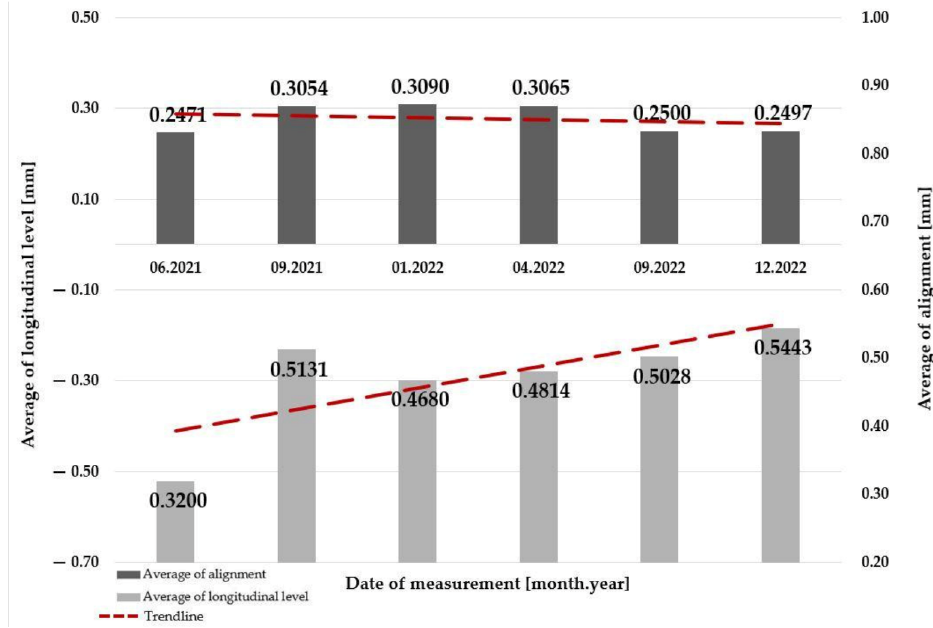
Figure 11. The change of average values of longitudinal level and alignment in Section